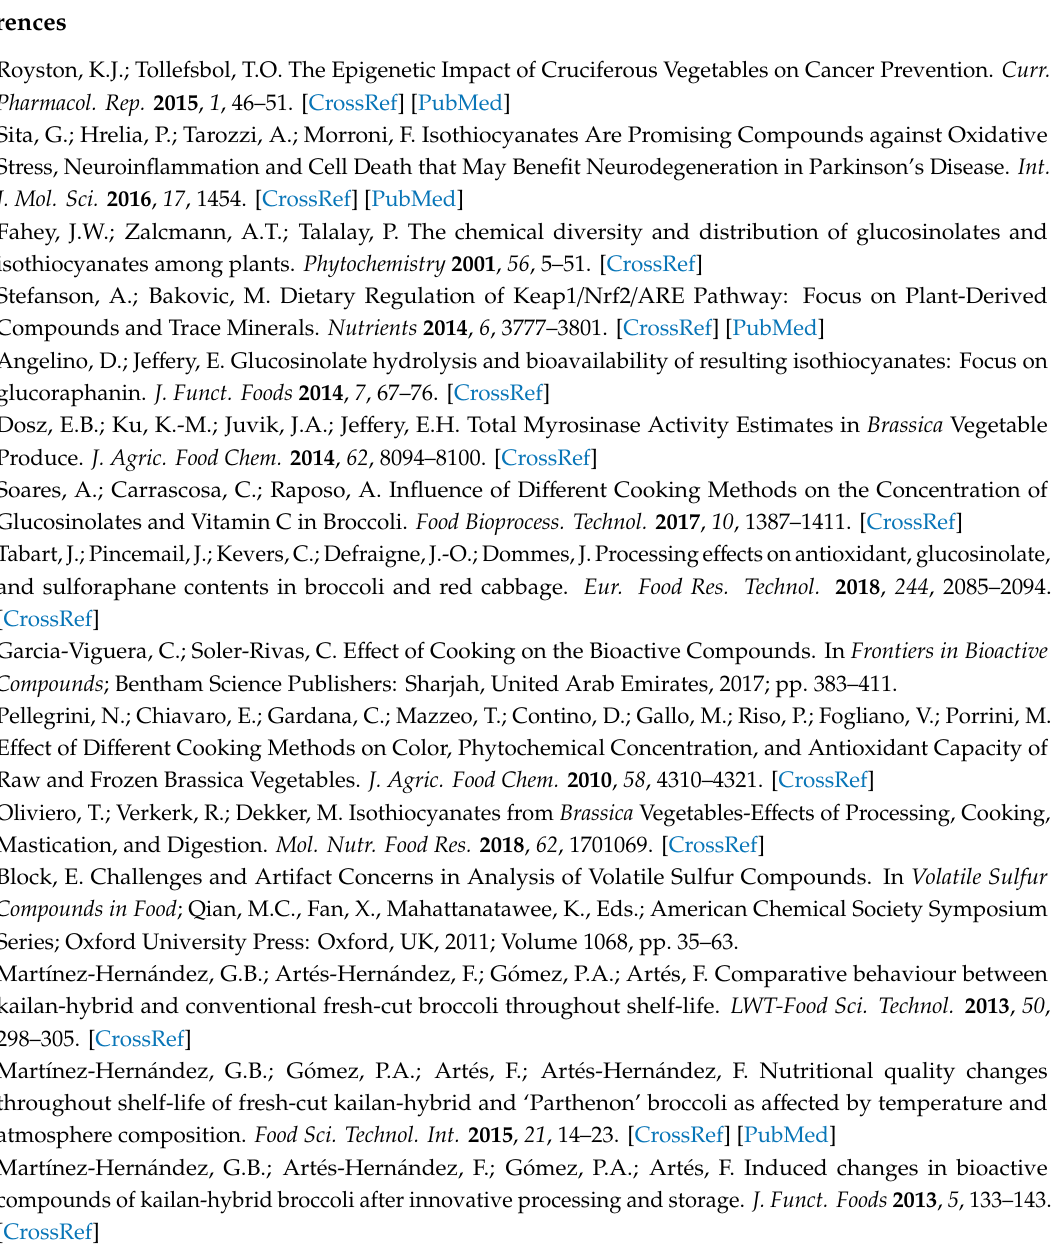
Figure S1: Identification of glucosinolates in fresh Brassica samples following their MS 2 [M − H] − fragmentations in HPLC-DAD-ESI-MS n